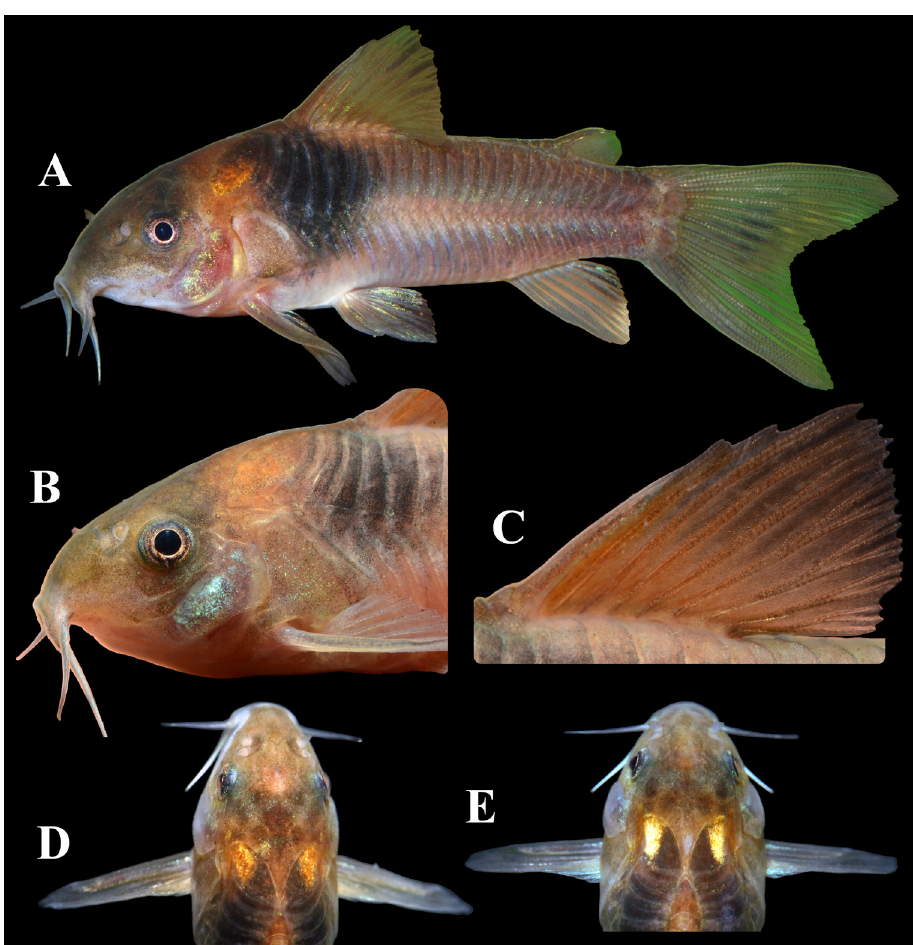
FIGURE 9 | Uncatalogued aquarium specimens of Corydoras maclurei (not measured) showing variations of the color pattern in life: specimens can variably present greyish orange ( A ) or reddish orange ( B ) ground color of body. In C , the detail of a conspicuously reddish orange dorsal fin. Anterior portion of first dorsolateral body plate typically with orange ( D ) or yellow ( E ) bright patch. Photographs ( D ) and ( E ) by Ian